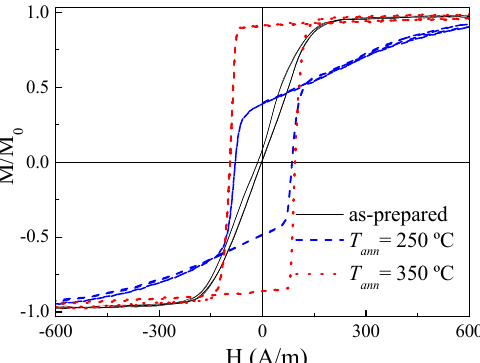
Figure 2. Hysteresis loop of as-prepared and annealed without stress at di ff erent T ann for T ann = 60 min